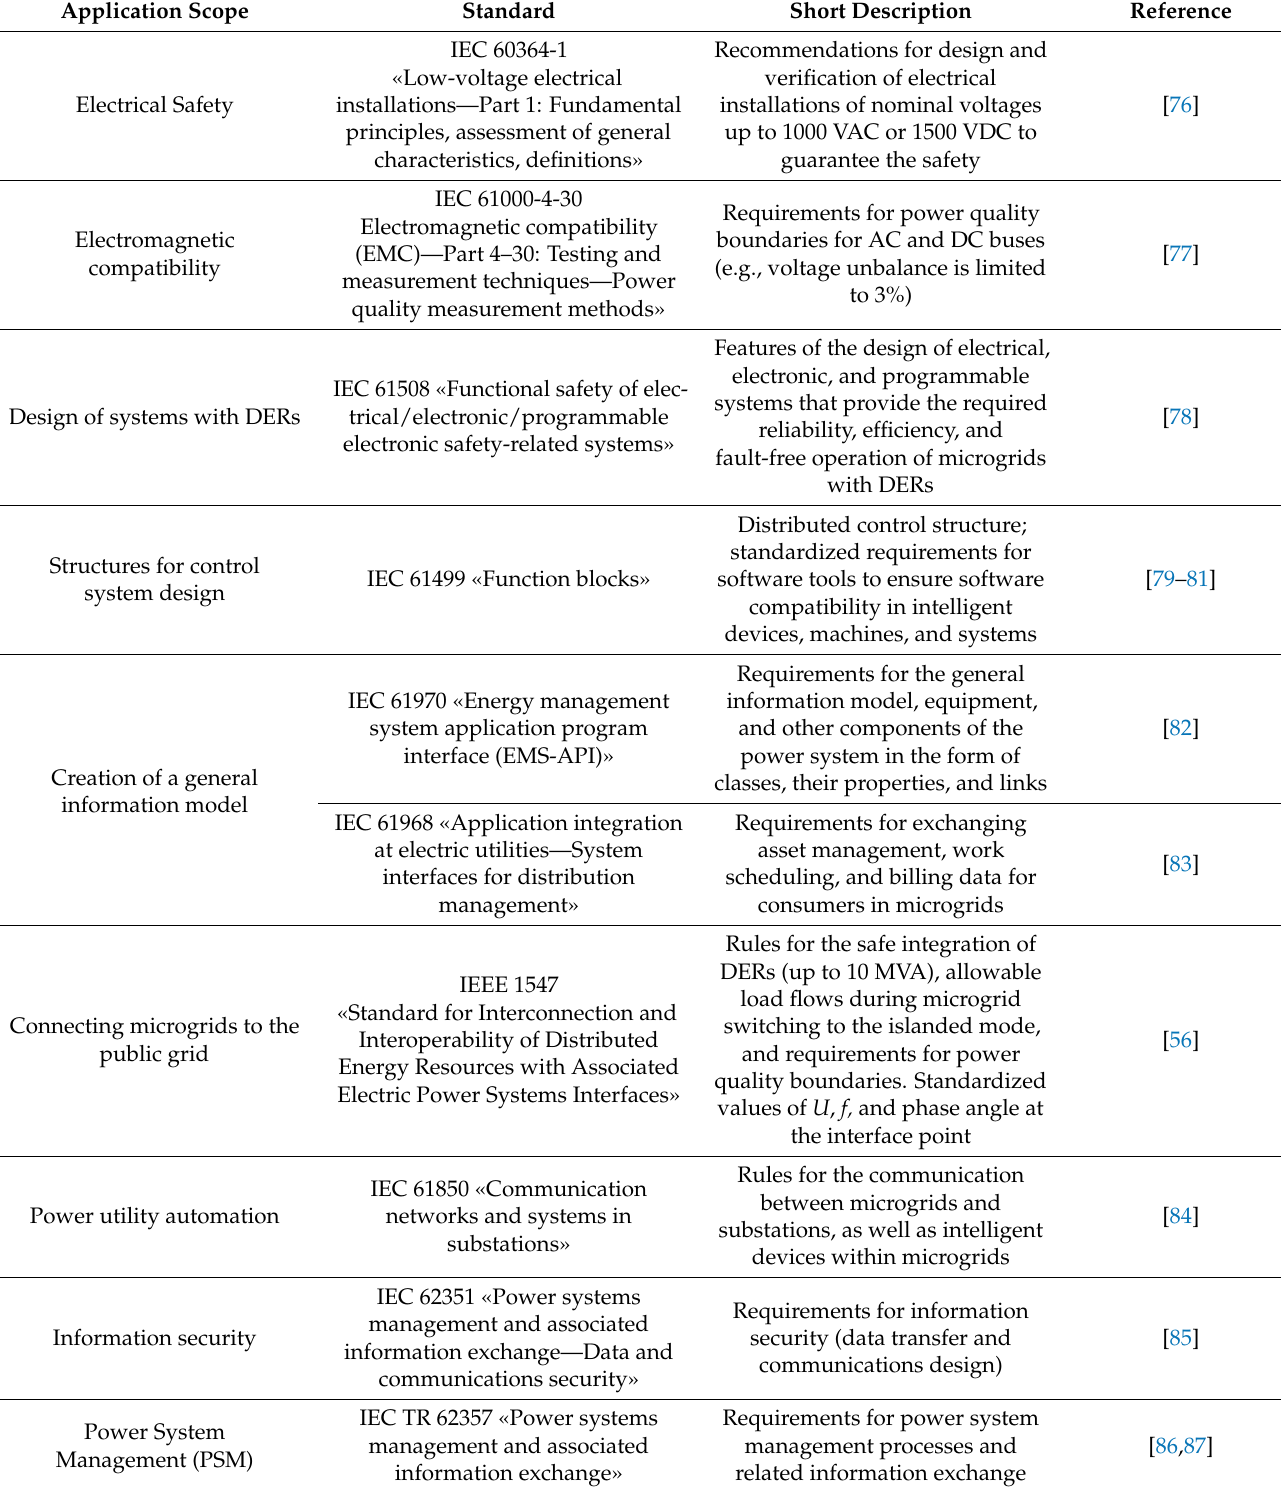
Table 1. Standards for the design of